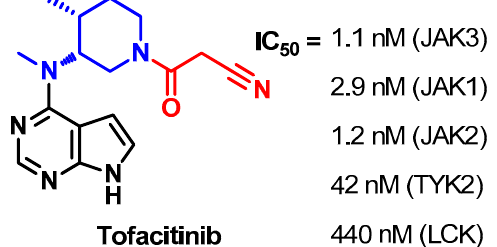
Figure 59. Kinase inhibitory activity of tofacitinib.